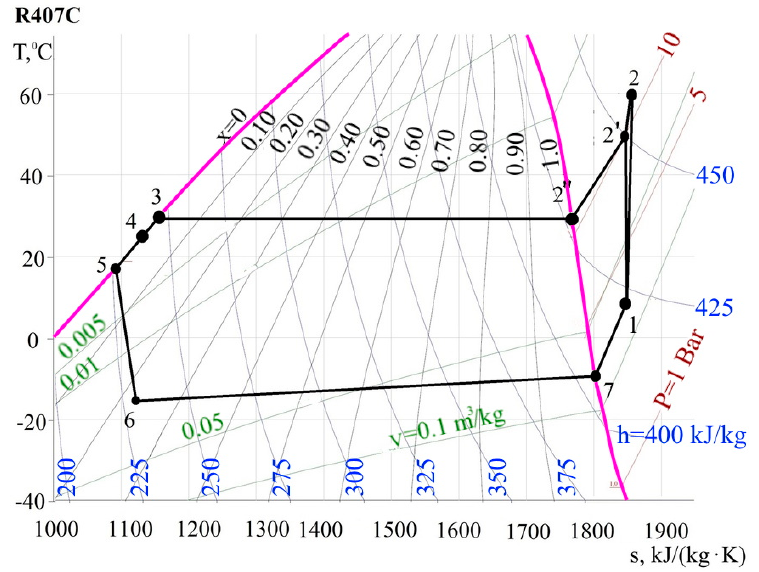
Figure 5. The diagram lg(p)-i. Calculations (Figure 6) of enthalpy values at the characteristic points of the cycle, as well as additional parameters are summarized in Table 1. They are recorded in the order of determination.